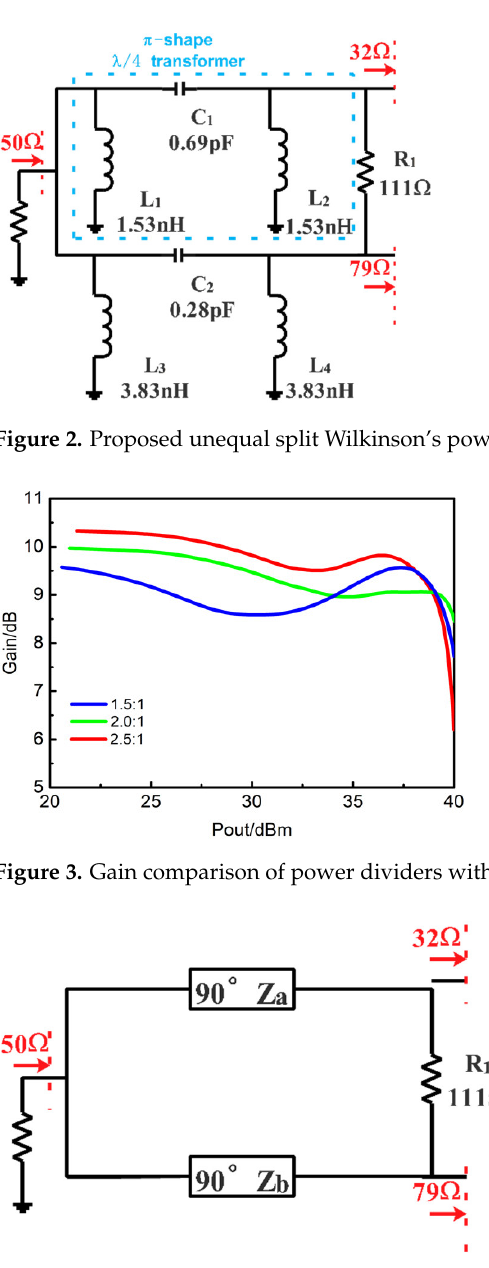
Figure 4. Traditional 90-degree transmission line (TL) power divider.